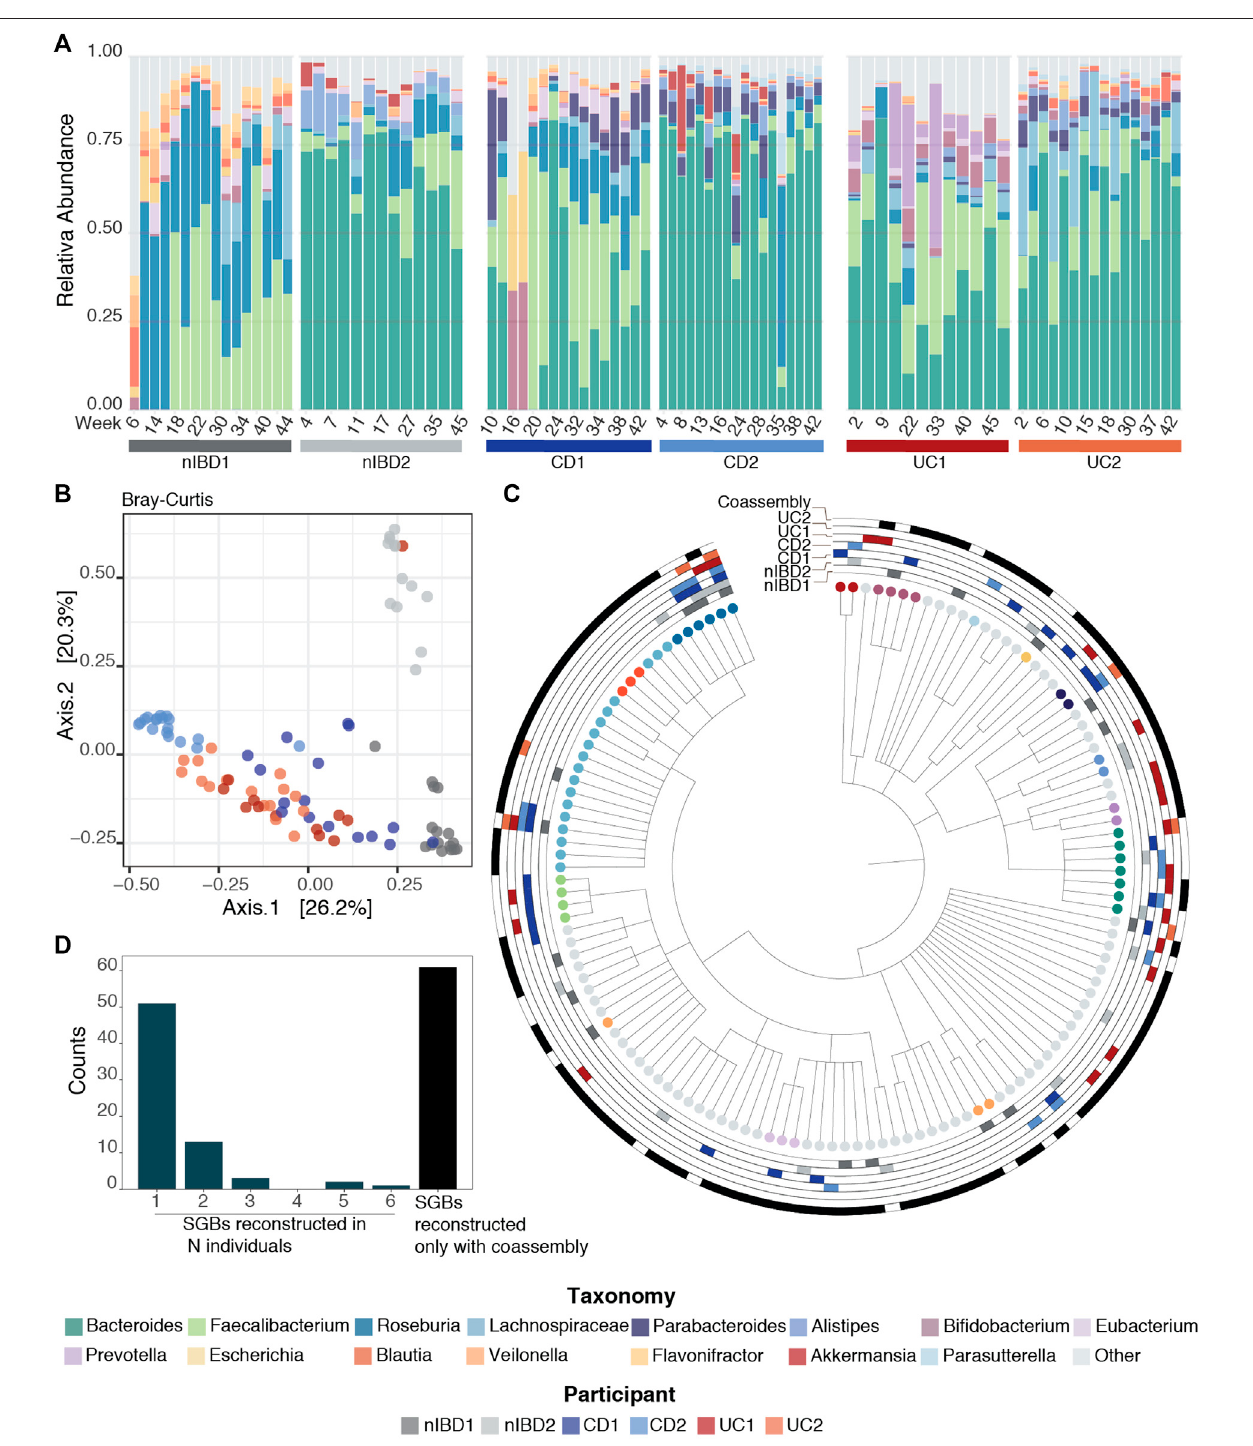
FIGURE2| Taxonomicpro fi les. (A) Relativeabundanceforthe91samplesforthe15mostabundantgeneraacrossthesamplesusingMetaPhlAn3(Beghiniet al., 2021). (B) Projection of the fi rst two principal coordinates based on Bray – Curtis dissimilarity from the microbiome composition using MetaPhlAn3 (Beghini et al., 2021). (C) Taxonomy tree representing the 131 SGBs taxonomies after running PhyloPhlAn3 (Asnicar et al., 2020) on the retrieved MAGs. The fi rst six rings mark MAGs that wereretrievedinthe6patientswiththedifferentconditionsusedinthiswork(nIBD,CDandUC),whilethelastringmarkstheMAGsobtainedfromco-assembly. (D) DistributionoftheSGBsinthe6patients:51SGBstaxonomieswereretrievedfromjustonesample,13fromtwosamples,3fromthreesamples,2from fi vesamplesand 1 in all the samples. The last bar represents the 61 taxonomies that were found only by having performed co-assembly.